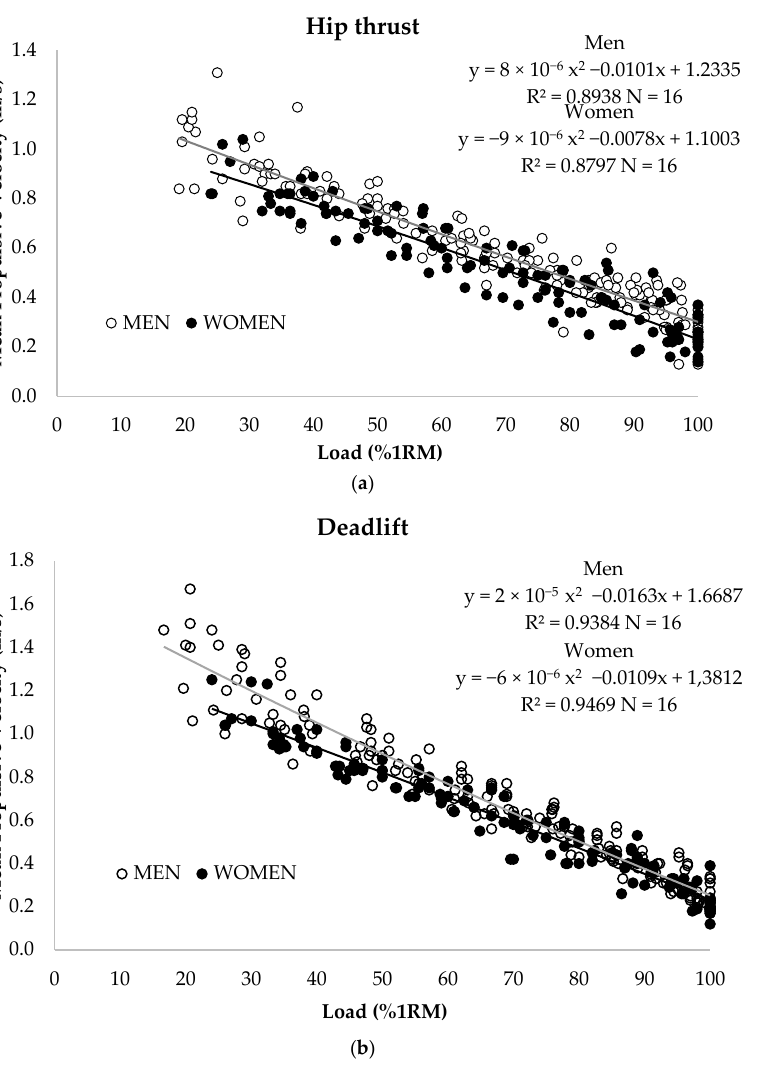
Figure 1. Relationship between relative load (%1RM) and mean propulsive velocity (MPV) for women (filled dots and solid line) and men (open dots and dashed line) in hip thrust ( a ) and deadlift ( b ). R 2 = Pearson’s multivariate coefficient of determination. N = number of trials included in the regression analysis.